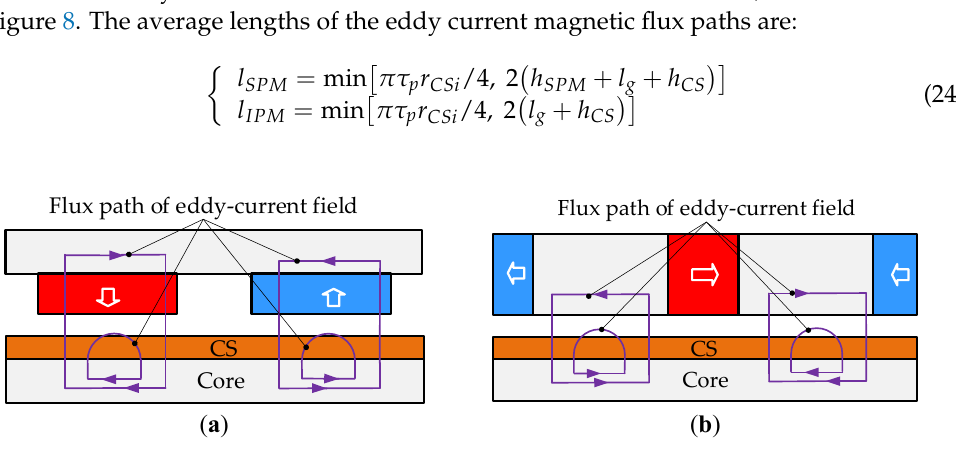
Figure 8. The flux path of eddy current field of the PMECCs with non-slotted CR: ( a ) Model − A; ( b ) Model − C.